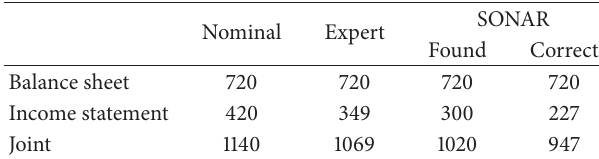
Table 2: Nominal, expert, and SONAR items identification results. Table 3: Nominal, expert, and SONAR items identification results divided into balance sheet and income statement items. SONAR Nominal Expert Found Correct Results 1140 1069 1020 947